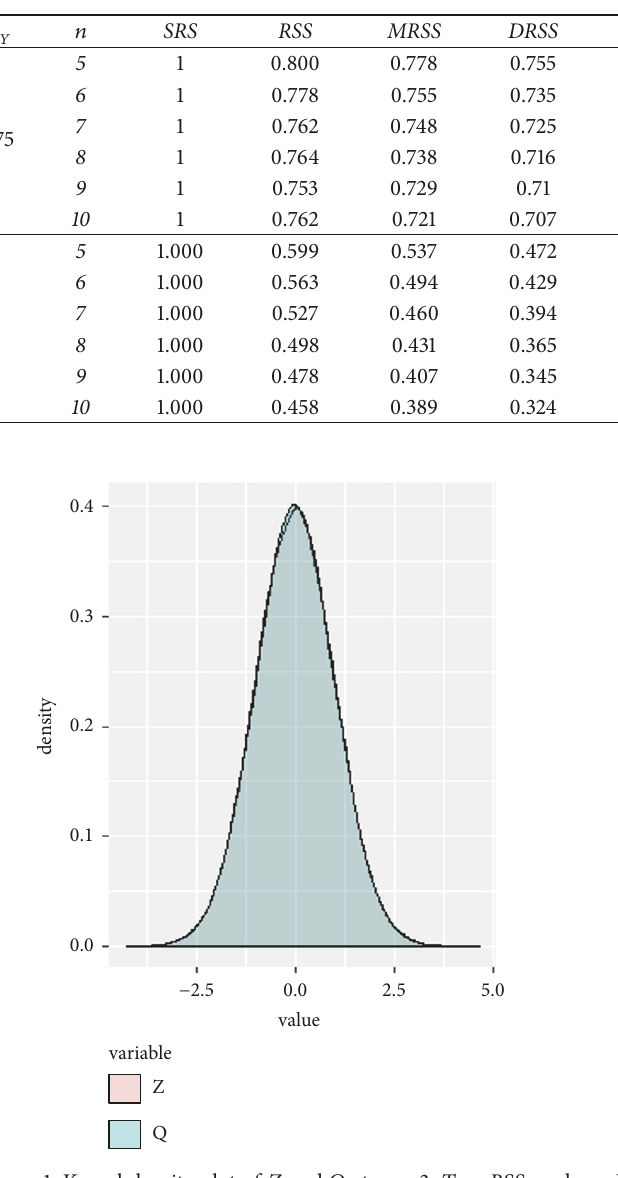
Figure 1: Kernel density plot of 𝑍 and 𝑄 at 𝑛 = 3 , 𝑇 = 𝑅𝑆𝑆 , and 𝜌 = 1 . 𝑋𝑌